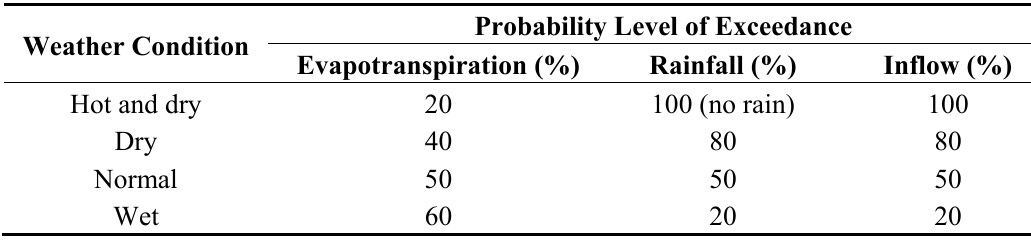
Table 2. Four defined weather